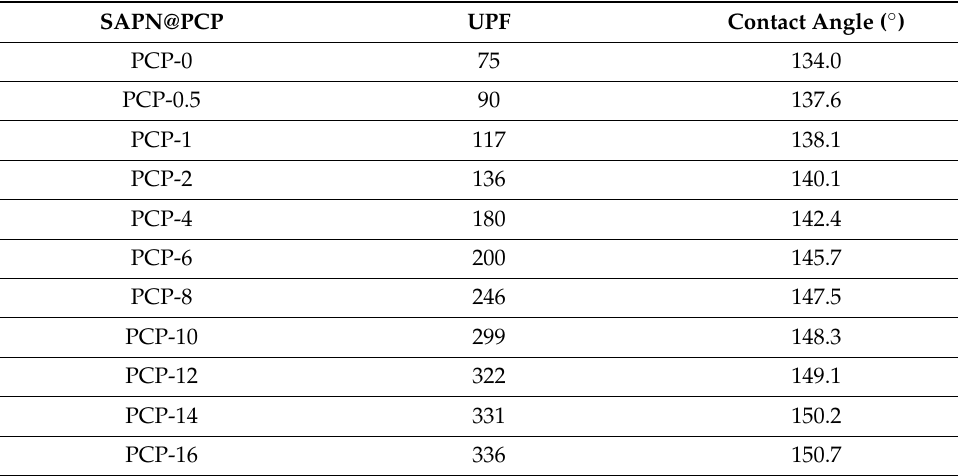
Figure 9. Fatigue resistance of PCP-12 (526 nm). Table 3. UPF and contact angle of